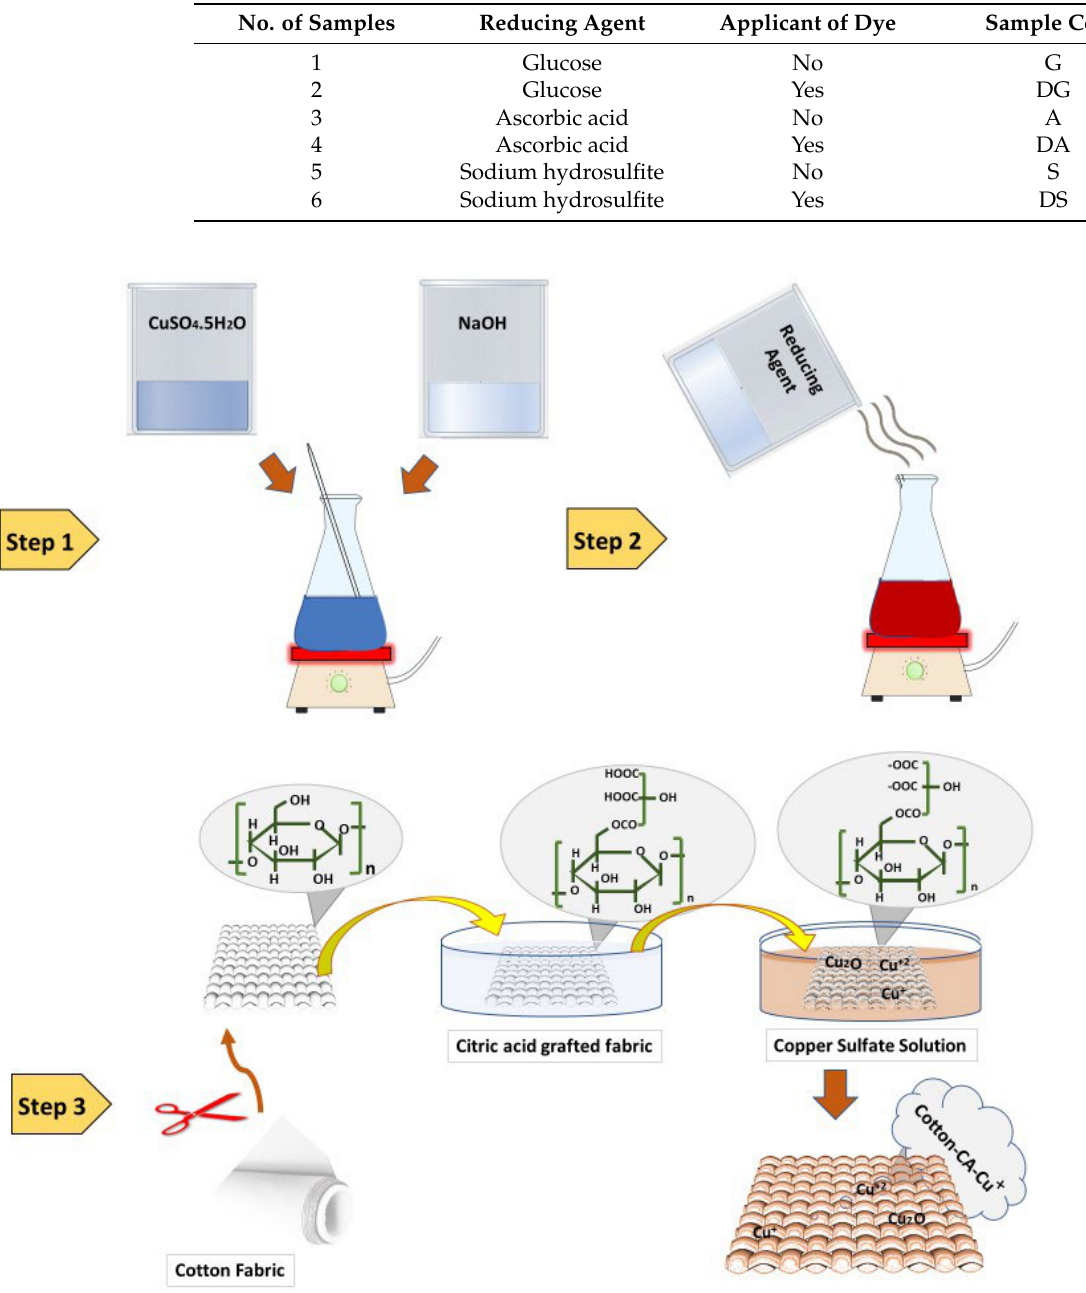
Figure 3. Schematic illustration of the three-step method involved in the synthesis of cuprous oxide particles and their subsequent deposition on cotton fabric.